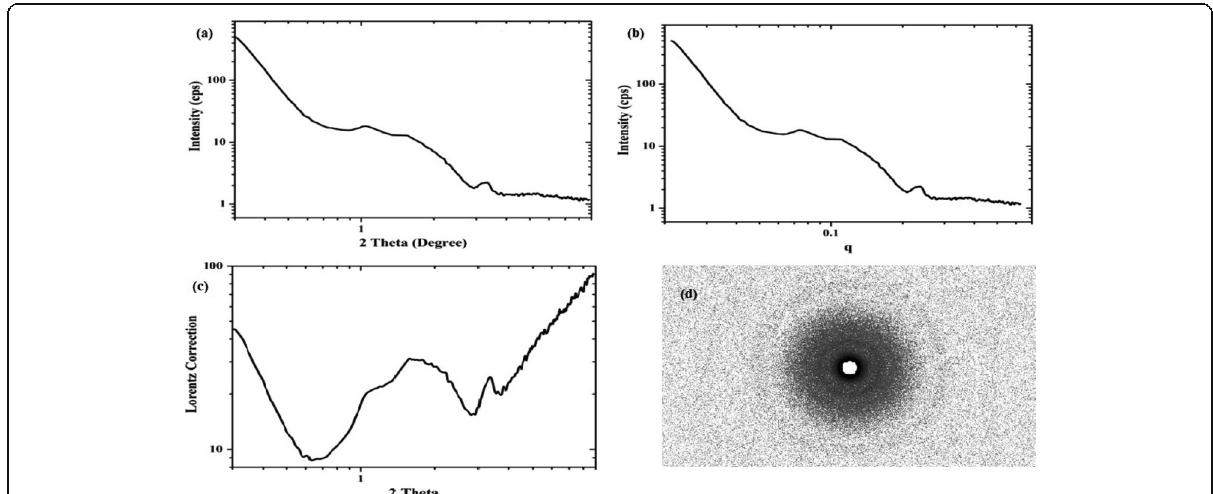
Fig. 2 Small angle X-ray scattering profile of topotecan liposome. a Intensity vs. 2 theta. b Intensity vs. q . c Lorentz correction. d 2D small-angle